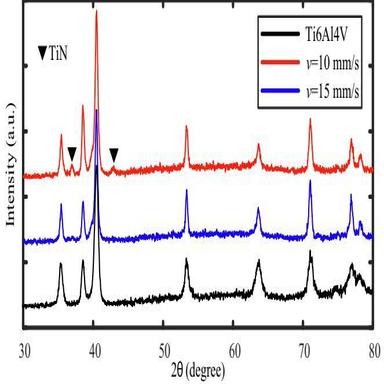
XRD patterns of the Ti6Al4V surface and the laser irradiated surfaces obtained under various scanning speeds (P = 1.48 W, r = 76.6 %, f = 700 kHz).